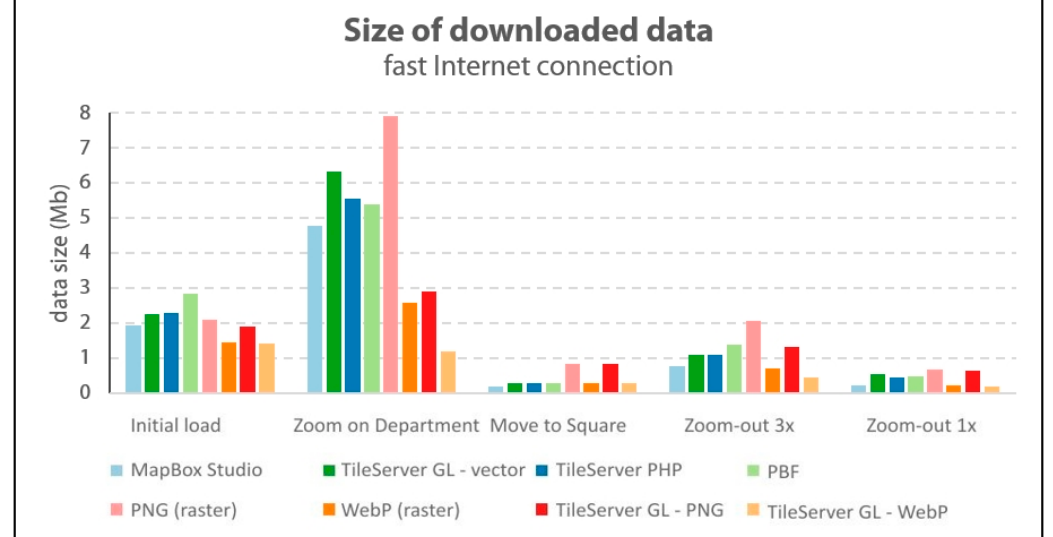
Figure 10. Results of the size of the downloaded data (slow Internet connection).